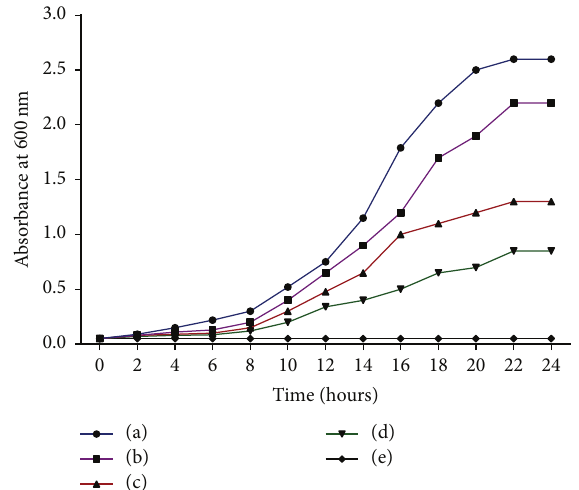
Figure 3: Growth of Bacillus aryabhattai strain PC-7 on minimal medium containing 10 mM glucose and (a) 0.5 mM 4-chloro-2- nitrophenol, (b) 1.0 mM 4-chloro-2-nitrophenol, (c) 1.5 mM 4- chloro-2-nitrophenol, (d) 2.0 mM 4-chloro-2-nitrophenol, and (e) 2.5 mM 4-chloro-2-nitrophenol.